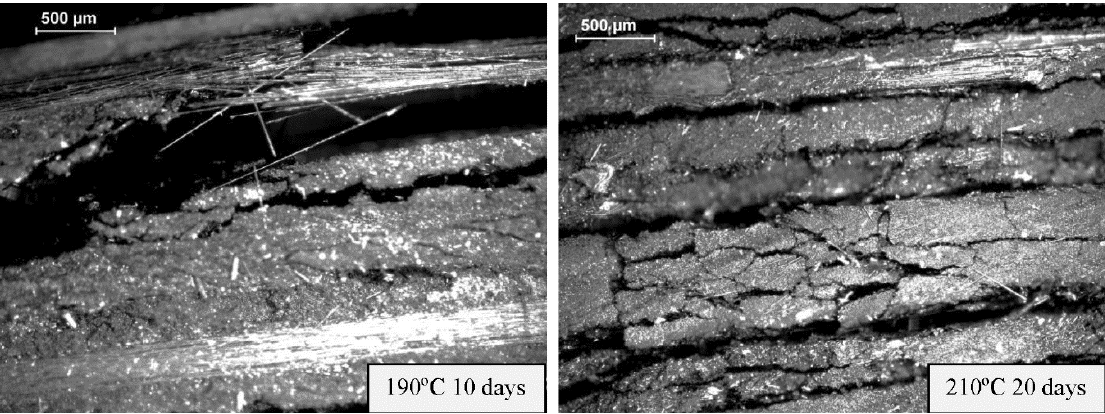
Figure 10 . Details of the CAI damage profiles during the CAI test of [0/90/±45] 2s quasi-isotropic Figure 10. Details of the CAI damage profiles during the CAI test of [0/90/ ± 45] 2s quasi-isotropic laminates aged at 190 °C for 10 days and 210 °C for 20 days. laminates aged at 190 ◦ C for 10 days and 210 ◦ C for 20